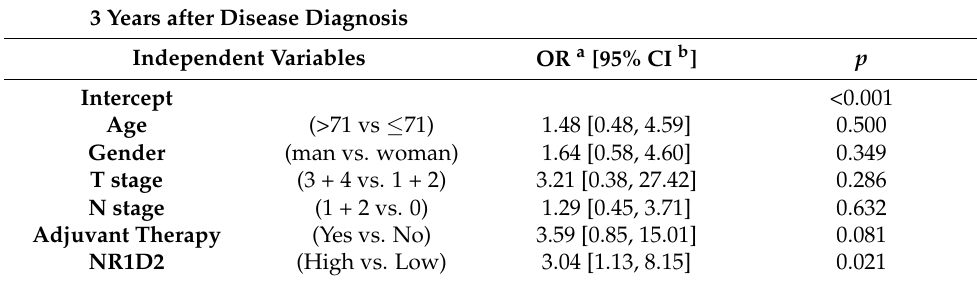
Table 9. Results of logistic regression for LR within 3 and 5 years after disease diagnosis.